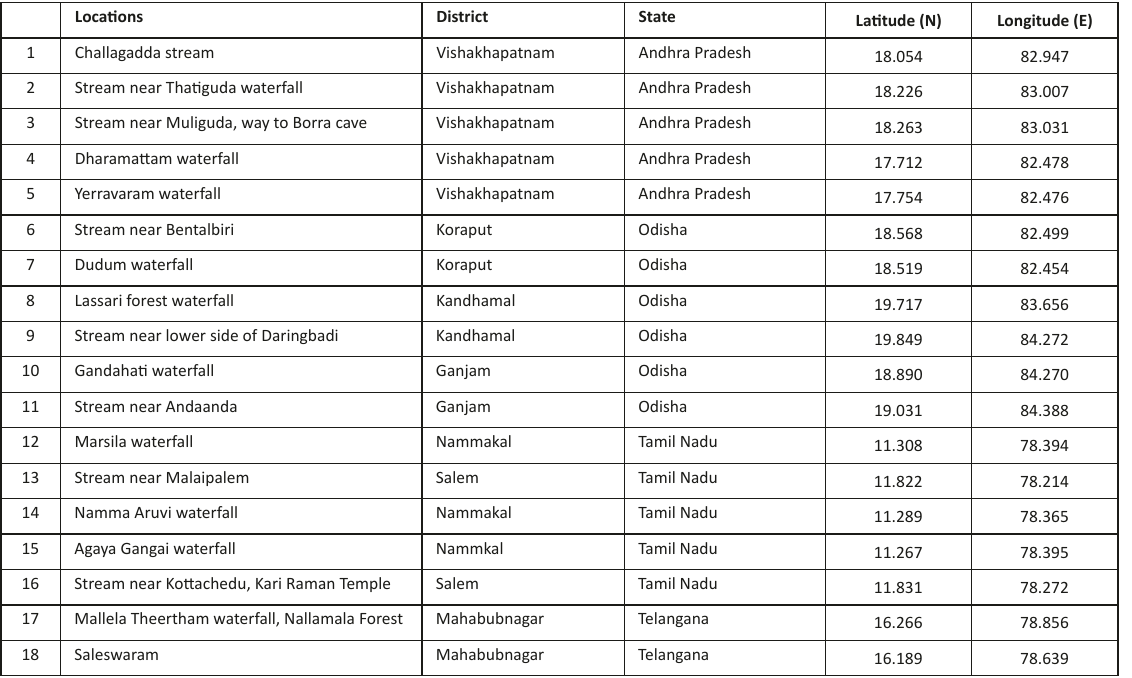
Table 1. Collections location of Ptilomera agriodes from different parts of Eastern Ghat regions, India.